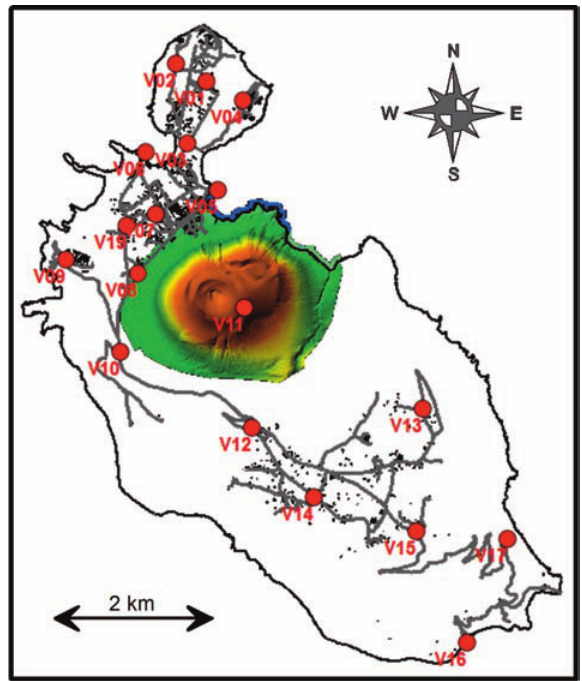
Figure 3. Maps of Easting (top), Northing (center) and position (bottom) residuals between the measured and calculated UTM WGS 1984 coordinates for the single GPS survey of July 27, 2008, at Vulcano Island. Red circles (V01-V17), GPS